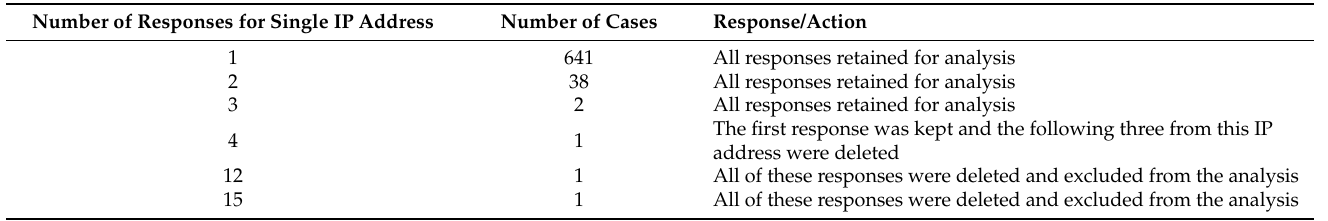
Table A1. Analysis of participants’ internet protocol addresses.